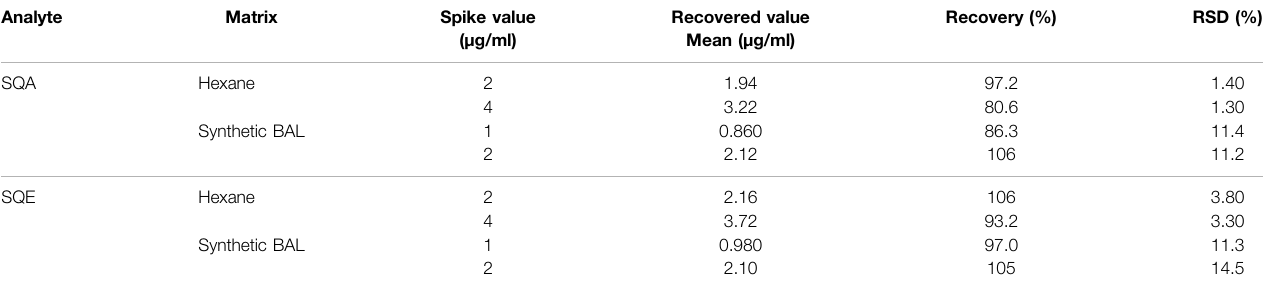
TABLE 1 | Analyte recovery for three forti fi ed matrices ( n ≥